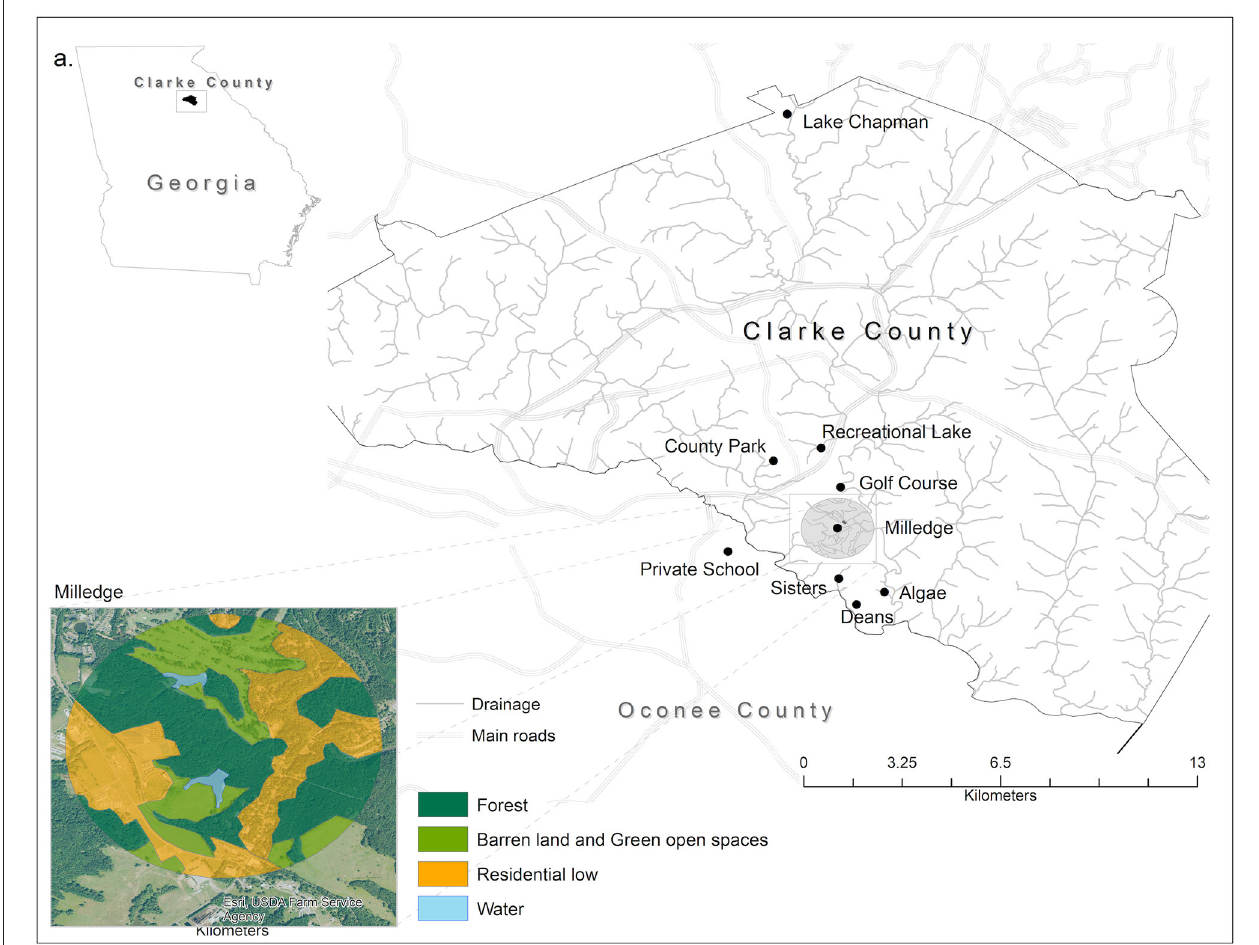
FIGURE 1 | Map of the eight capture sites where turtles were captured for Salmonella testing. Seven sites were in Athens-Clarke County, Georgia (Algae Pond, Sisters Pond, Lake Chapman, UGA Golf Course, Milledge Pond, County Park, and Recreational Lake) and one was in Oconee County, Georgia (Private School). Inset shows and example of the land use categories surrounding each sample site. Land cover data are derived from the National Agriculture Imagery Program (NAIP, 2016) by the USDA’s Farm Service Agency (FSA). Classes’ denomination is based on the National Land Cover Classification. ArcGIS 10.5 licensed to Salisbury University, MD was used to extract the land cover features. All vector data used can be found freely available at TIGER from the U.S. Census Bureau